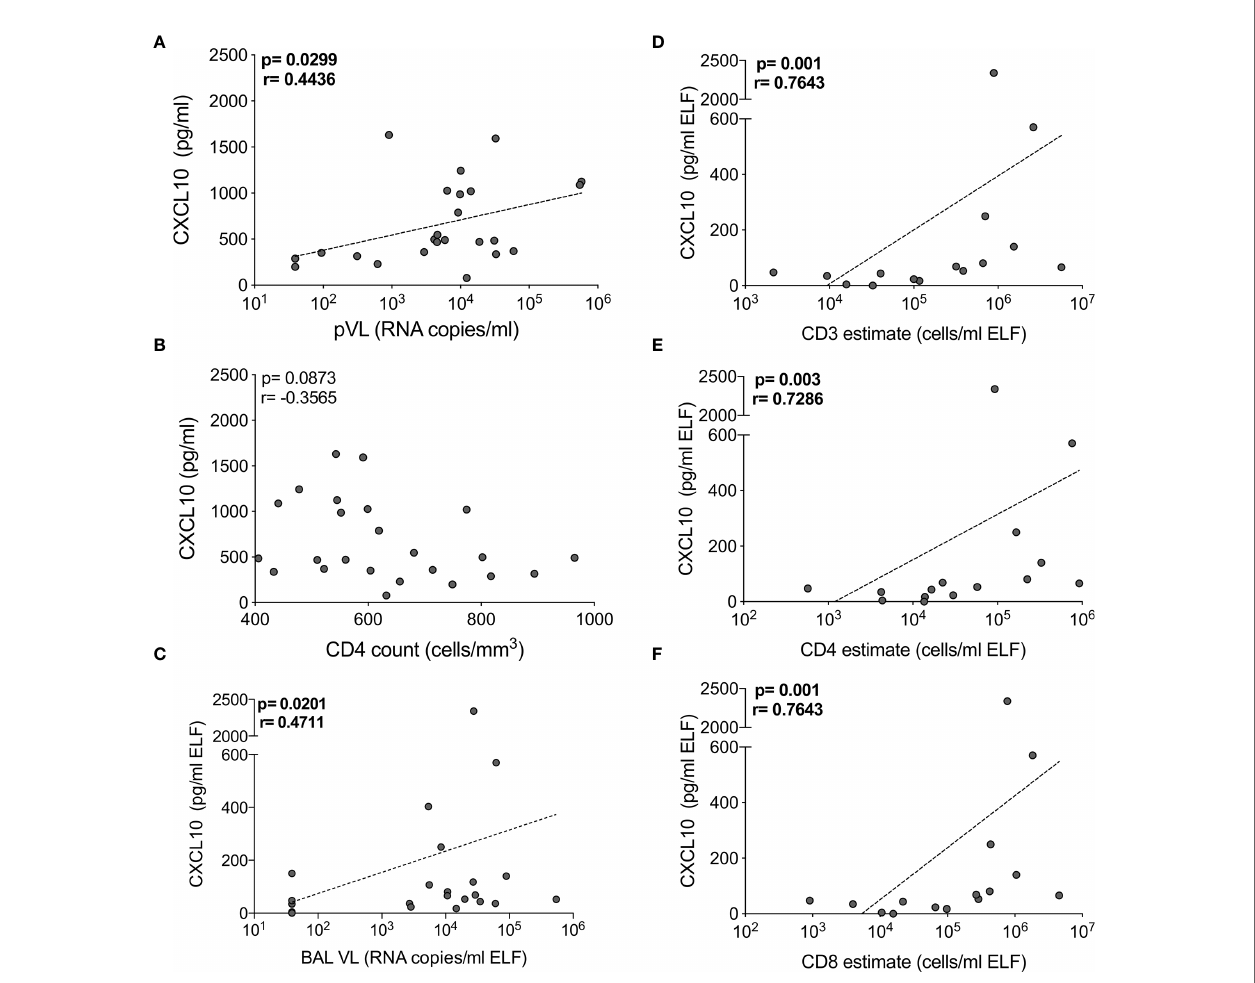
FIGURE 4 | CXCL10 correlates with HIV viral load and T cell numbers in BAL of HIV-infected individuals. The correlation between CXCL10 concentration and (A) plasma HIV viral load, (B) blood CD4 count in blood, (C) BAL HIV viral load (n=24), (D) BAL CD3, (E) CD4 and (F) CD8 T cell estimates (n=16). Each dot represents an individual. Only individuals with absolute BAL cell count data were plotted. The dotted line indicates linear regression for statistically signi fi cant correlations. Statistical analyses were performed using a non-parametric Spearman rank